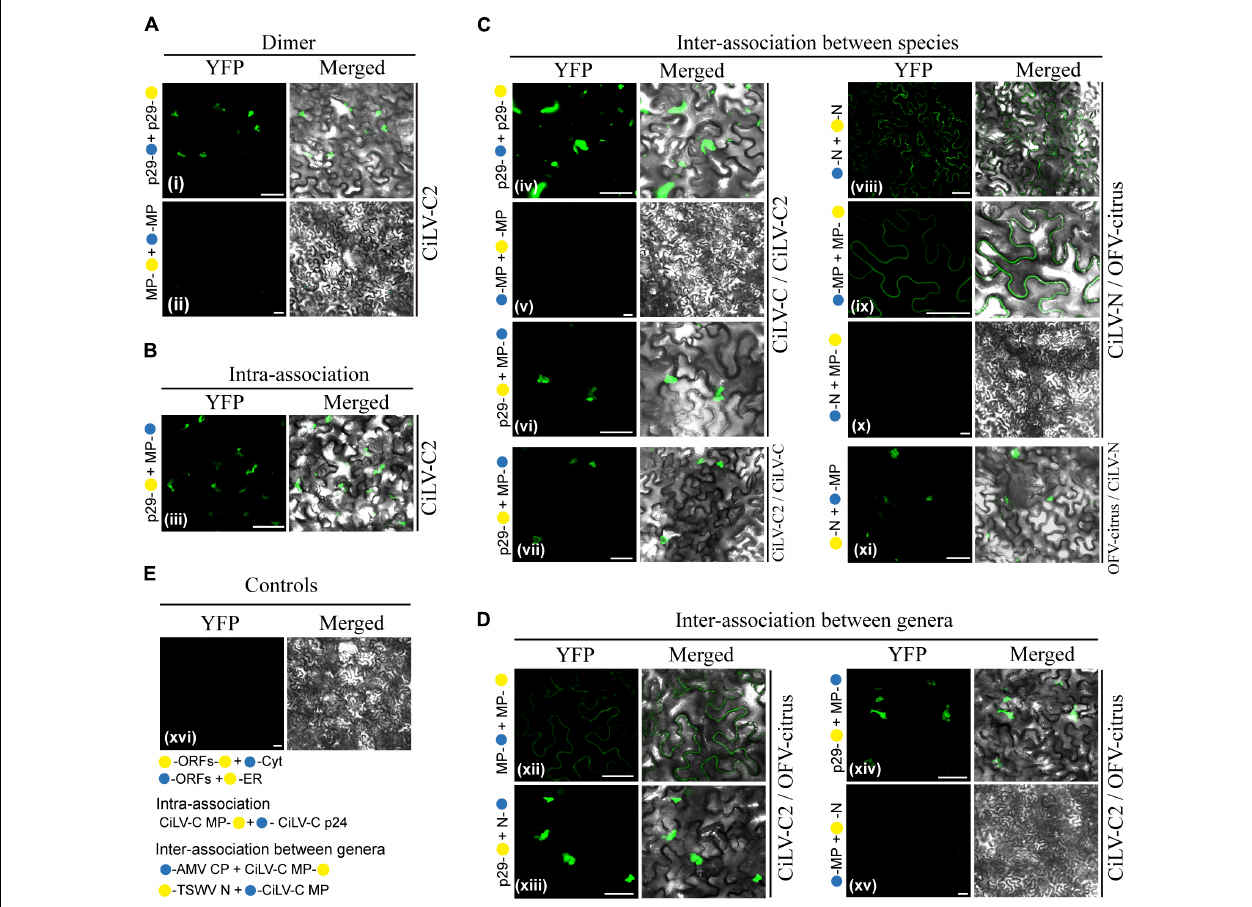
FIGURE 7 | BiFC analyses of the transient expression combinations between movement proteins (MP), nucleoproteins (N), and capsid protein (p29) from distinct BTVs. Dimer (A) , intra (B) , and inter (C,D) interactions of the p29 and MP of the CiLV-C2, and Ns and MPs of the CiLV-N and OFV-citrus, were analyzed by BiFC. p29, Ns and MPs carrying N-terminal ( • ) or C-terminal ( • ) YFP fragments fused at their N- ( • / • -ORFs) or C-termini (ORFs- • / • ) were transiently co-expressed in N. benthamiana leaves by agroinfiltration. Representative protein pair combinations are indicated at the left of each image; all hetero-combinations performed are shown in Table 3 . All images contain two pictures corresponding to the YFP signal or merged with bright field. The YFP fluorescence reconstitution was monitored at 4 days post-infiltration using a confocal laser scanning microscope Zeiss LSM 780 model. Suggested positive interactions were visualized in (i,iii,iv,vi–viii,ix,xi–xiii,xiv). No interactions are indicated in (ii,v,x,xv,xvi). Negative controls correspond to the expression of the respective proteins in combination with Cyt or ER BiFC vectors (E) . Additional negative controls are presented for the intra-association: CiLV-C MP + p24 (putative matrix protein) (Leastro et al., 2018) and for the inter-association between genera: AMV CP + CiLV-C MP and TSWV N + CiLV-C MP (Leastro et al., unpublished) (E) . All images displayed are representative of three independent experiments. Bars correspond to 50 µ